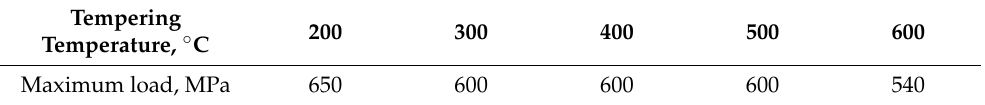
Table 3. Maximum loads during the test, depending on the tempering temperatures.